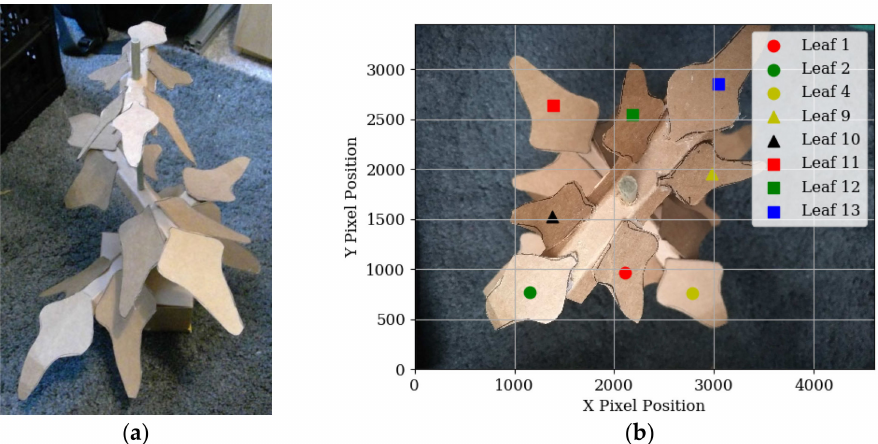
Figure 9. ( a ) Artificial plant used to test the capabilities of the leaf detection grouping algorithm. The plant was photographed in the same manner as the leaves in Figure 6 and labelled manually because the neural network was not trained to detect the fake leaves. ( b ) shows the centre position of each manual detection of one of the photographs.